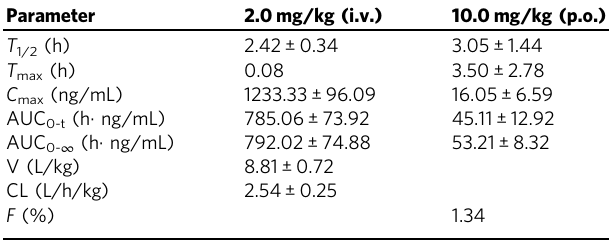
Table 6 Pharmacokinetics pro fi les of 18b1 a . Parameter